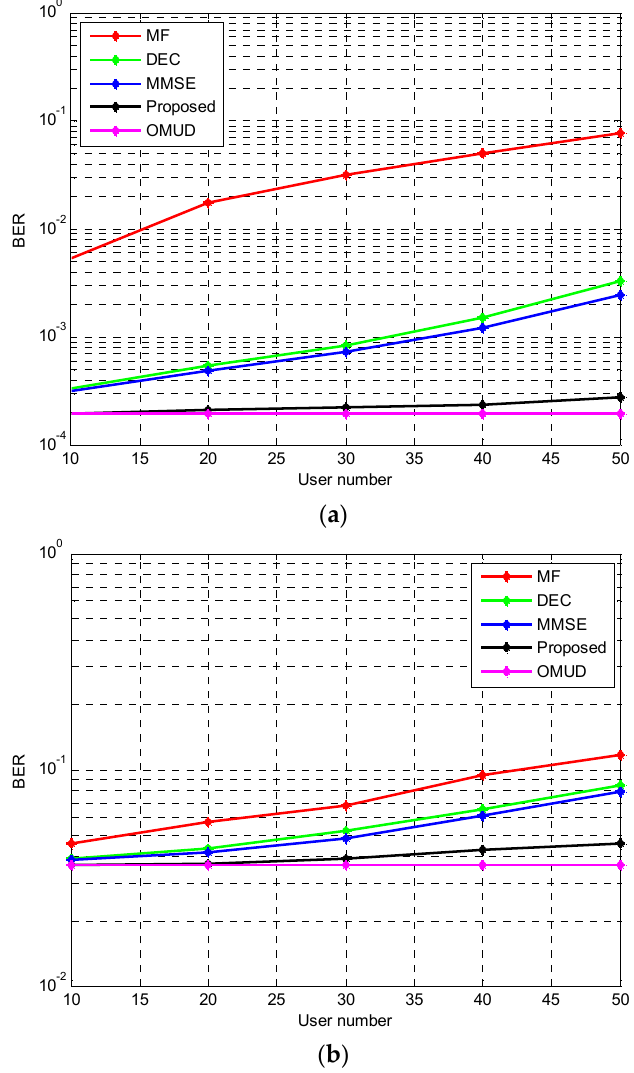
Figure 8. The BER performance with different number of users. ( a ) AWGN; ( b ) IEEE 802.15.4a CM1.